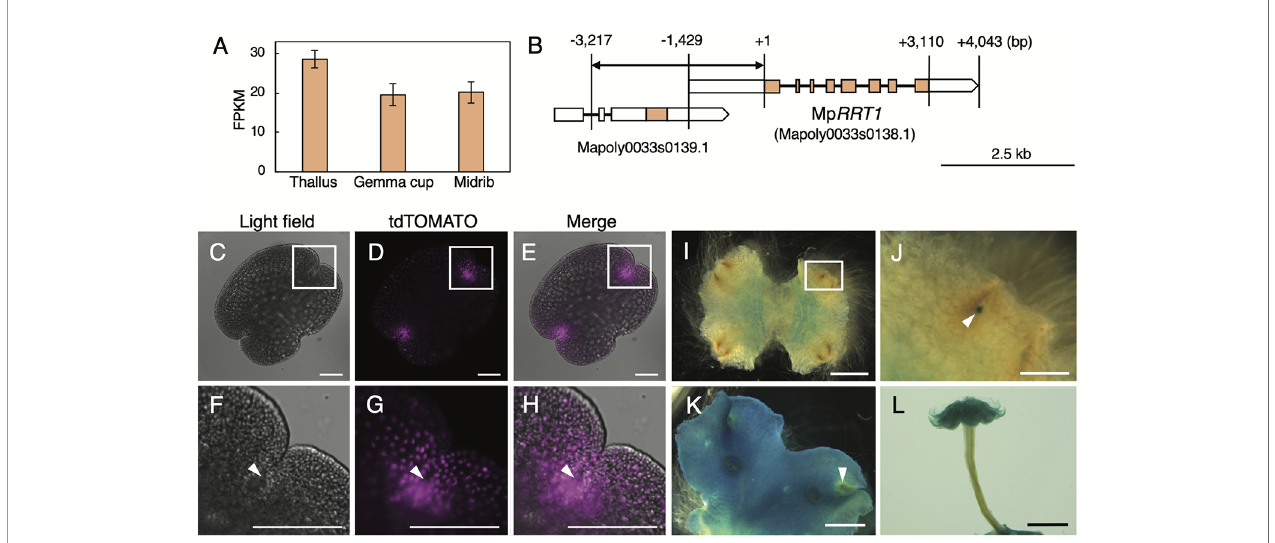
FIGURE 4 | Expression pro fi les of Mp RRT1 in liverwort. (A) Expression pro fi le of Mp RRT1 based on RNA-Seq data. Expression levels of Mp RRT1 in the thallus, gemma cup, and midrib were estimated based on the relative abundances of transcripts with the unit fragments per kilobase million (FPKM). The values are presented as the mean of three biologically independent samples with SD. (B) Schematic representation of the structure of the Tak-1 Mp RRT1 (Mapoly0033s0138.1) and the adjacent gene locus based on Marpolbase and sequencing results in this study. Orange and white boxes represent predicted exons and UTRs, respectively. Black lines represent introns. A bidirectional arrow indicates the promoter region used in reporter analyses. (C – H) Expression pattern of pro Mp RRT1 : tdTOMATO in gemma. Images of light fi eld (C, F) , fl uorescence images of tdTOMATO (D, G) , and their merged images (E, H) are shown. Magni fi ed images of the white squares in the upper panels are presented in the images in lower panels. White arrowheads indicate the apical notch. (I – L) GUS staining of pro Mp RRT1 : GUS in 11-day-old thalli (I , J), 19-day-old thalli (K) , and antheridiophores (L) . (J) is a magni fi ed image of the area of the white squares of (I) . White arrowhead indicates GUS staining at the apical notch. Scale bars, 100 m m (C – H) , 500 m m (J) , 2 mm (I, K) , and 5 mm (L)